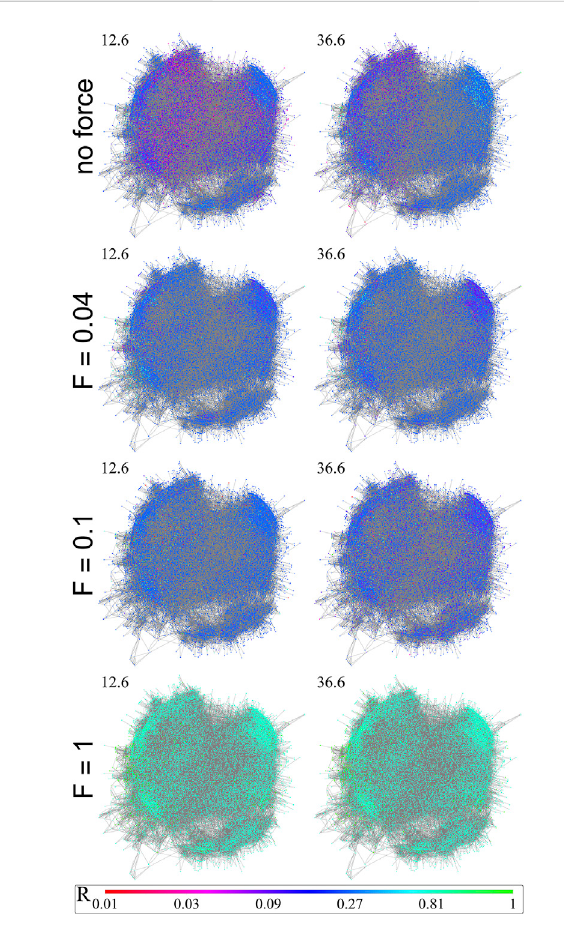
FIGURE 7 Here we see the evolution of the local order parameters R i ( t ) of a sub-graph of thefruit- fl y connectome atdifferent time steps: t = 12.6, 36.6. The upper row shows R i map without a force, the lowest one with F =1.0.Color-codingatthebottomprovides R i ( t )forallsub- fi gures.